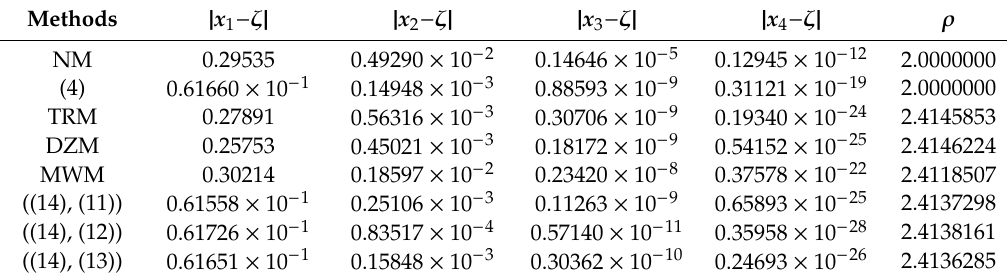
Table 6. Numerical results for function f 6 ( x )